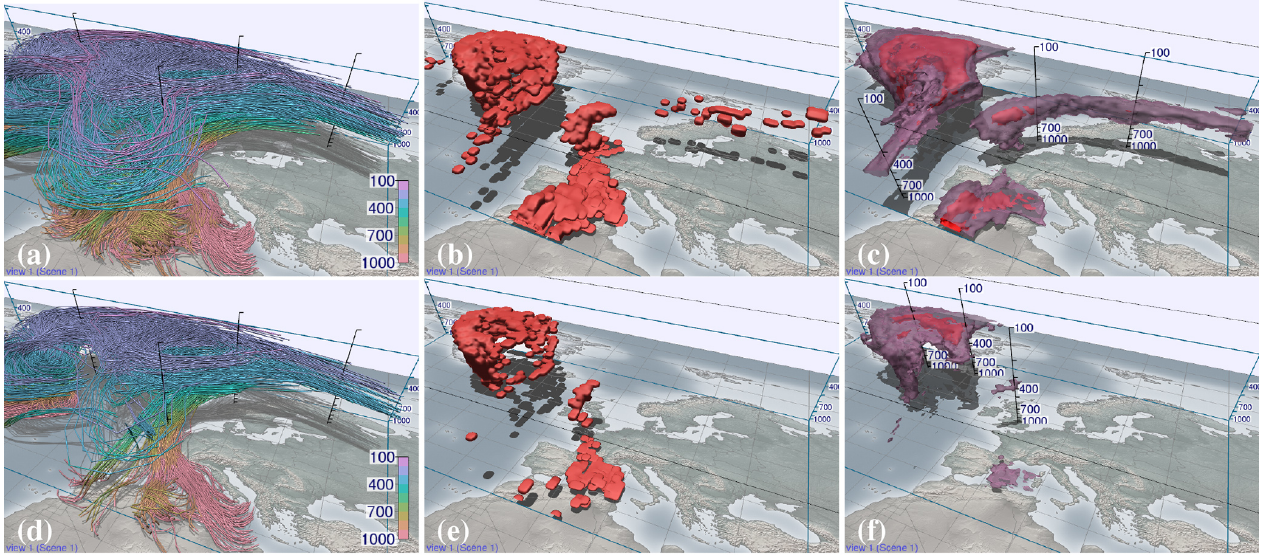
Figure 3. Derivation of p( WCB ) with DF-T set-up (S3). (a, d) Trajectories started at 18:00UTC, 19 October 2012, computed with wind fields from the ensemble control forecast from 00:00UTC, 17 October 2012, integrated forward and backward in time for 48h each. Trajectories are selected according to an ascent of (a–c) 500 and (d–f) 600hPa in 48h. Colour encodes altitude (hPa). (b, e) Volume rendering of the binary grid B , representing the start positions of the selected trajectories. (c, f) Probability of WCB occurrence derived from all 51 members of the ensemble. The red opaque isosurface shows 30% probability, the purple transparent isosurface 10% probability. Vertical axes are labelled with pressure altitude